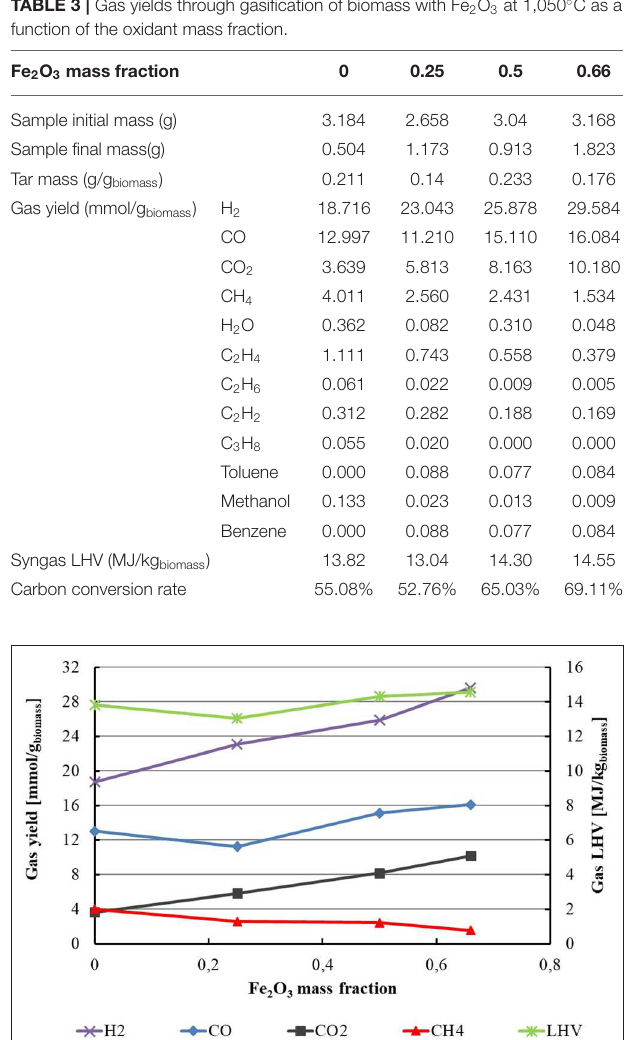
FIGURE 8 | Gas yield at 1,050 ◦ C and LHV of the produced gas according to the Fe 2 O 3 mass